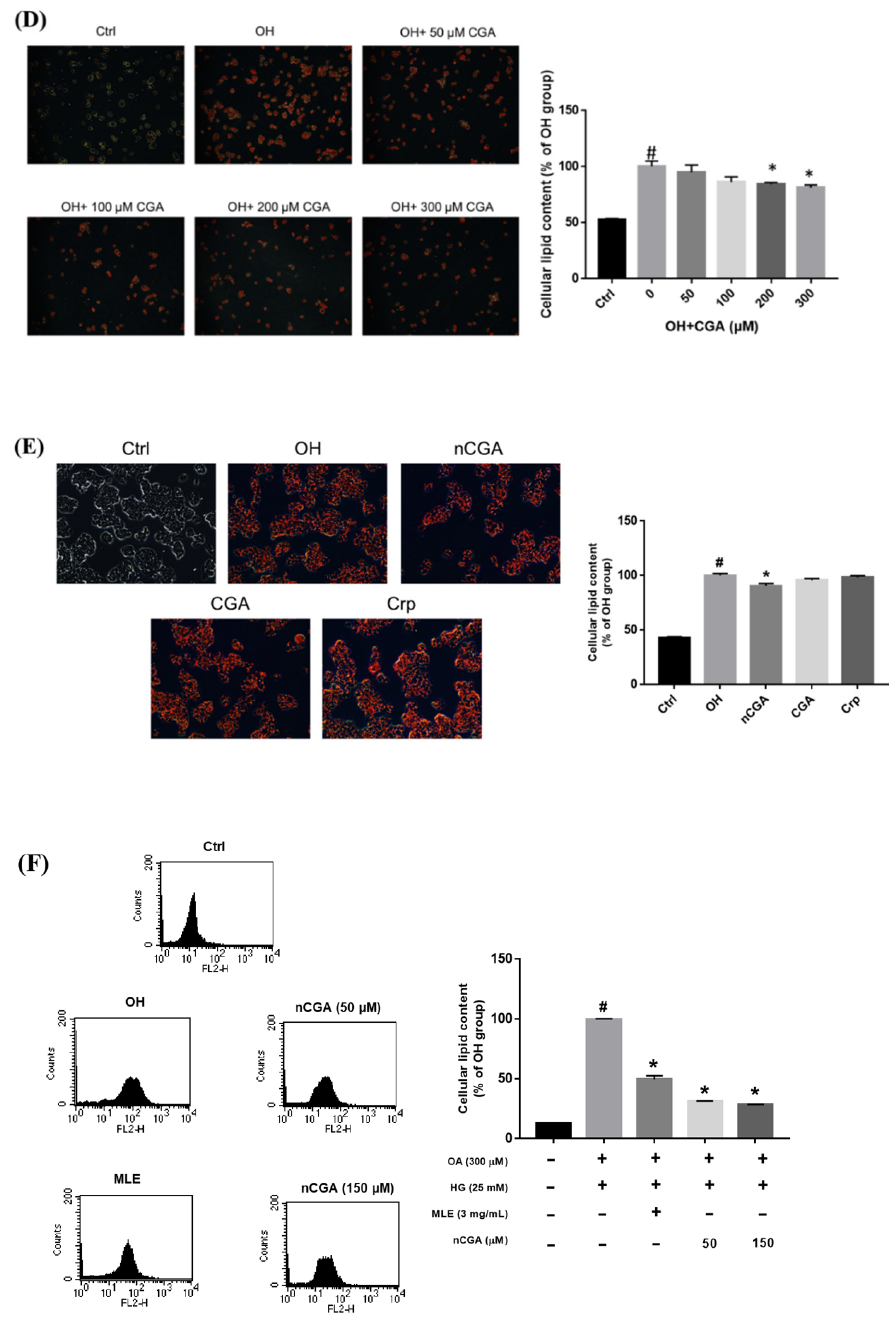
Figure 3. Effect of MLE and CGA isomers on lipid accumulation in OH − treated HepG2 cells. HepG2 cells were treated with 300 µ M oleic acid + 25 mM high glucose (OH) and various concentrations of ( A ) MLE ( B ) nCGA ( C ) Crp and ( D ) CGA at 37 ◦ C for 24 h. Intracellular lipid accumulation was measured by oil red O staining. ( E ) The different alleviation effects of these CGA isomers on lipid accumulation in the HepG2 cells; nCGA had the most significant alleviation effect when compared with the other two CGA isomers. ( F ) The lipid accumulation in HepG2 cells was inhibited as determined by Nile red staining. Values are the mean ± SD from three replicates per treatment. # p < 0.05 vs. the control group. * p < 0.05 vs. the OH group.